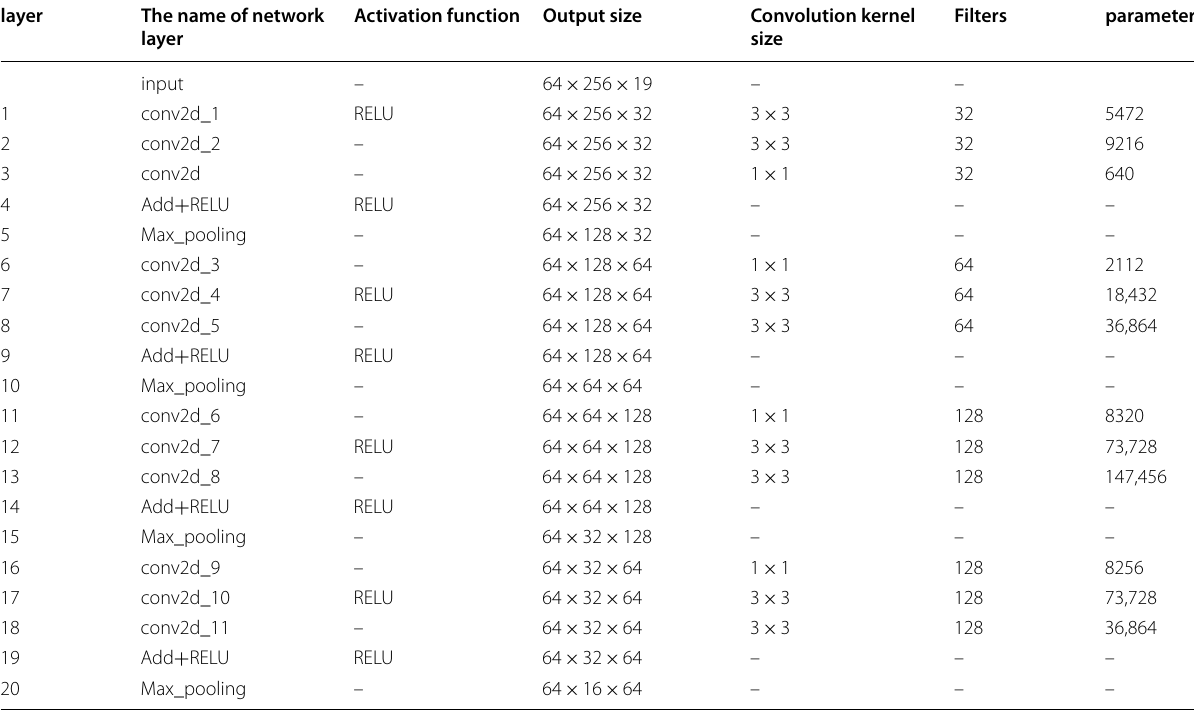
Table 2 The detailed Resnet parameters layer The name of network Activation function Output layer